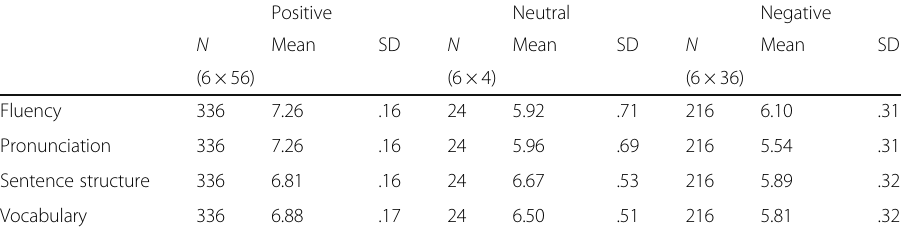
Table 2 Mean and standard deviation for proficiency variables by three attitude groups of raters Positive Neutral